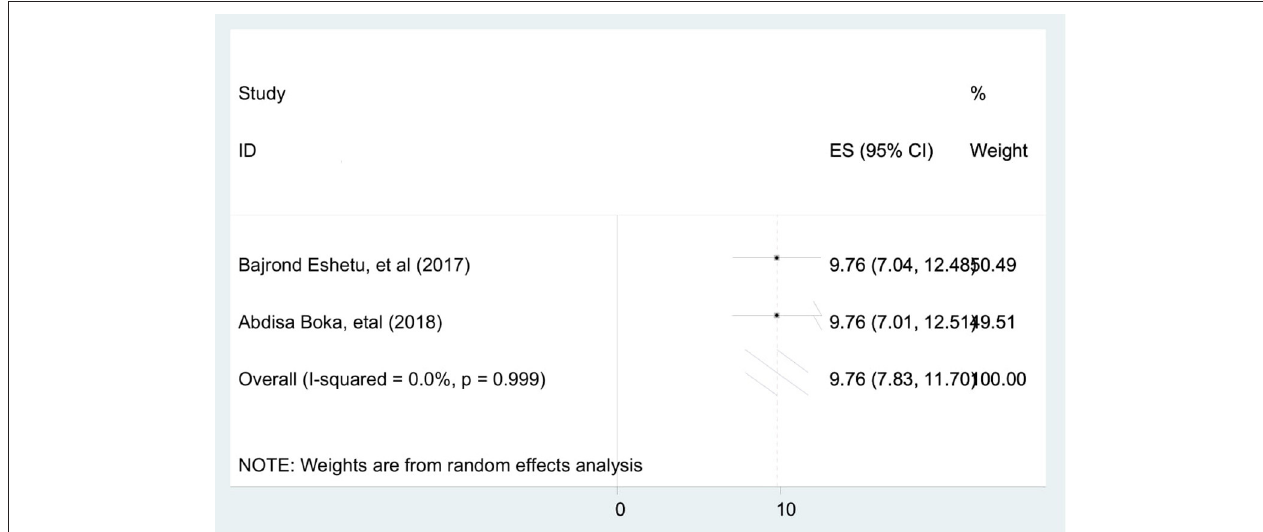
FIGURE 6 | Forest plot to show the association between gestational age of < 37 completed weeks and pooled prevalence of stillbirths among diabetic pregnant mothers in Ethiopia,